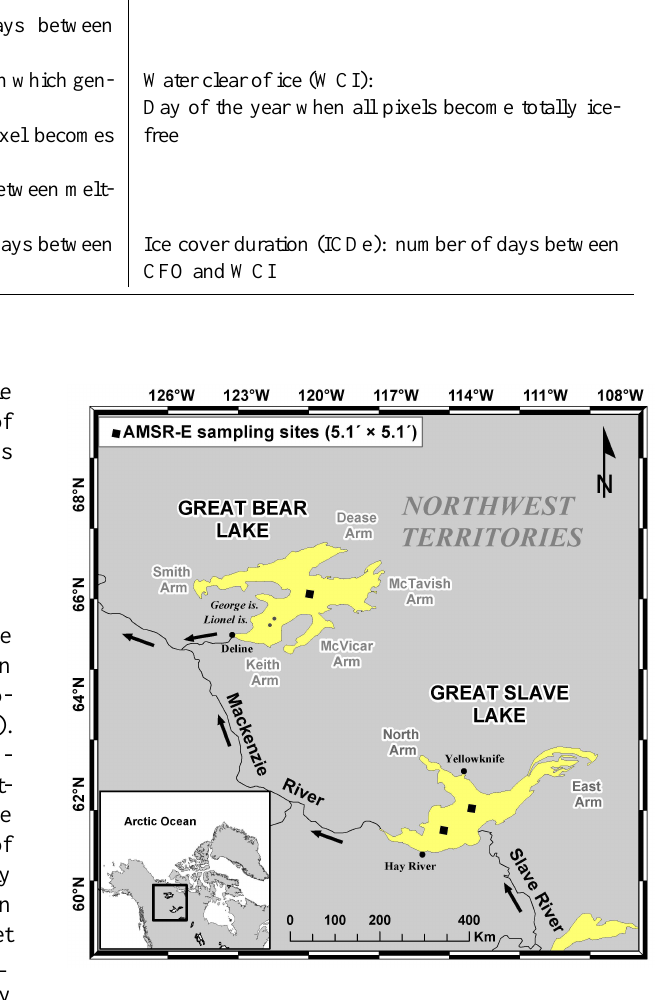
Fig. 1. Map showing location of Great Bear Lake (GBL) and Great Slave Lake (GSL), and their meteorological stations (Deline, Yel- lowknife, and Hay River) within the Mackenzie River Basin. Solid squares represent 5.1 0 × 5.1 0 (9.48km × 9.48km) of sampling sites at 18.7GHz for the development of the ice phenology algorithm. Arrows indicate river flow